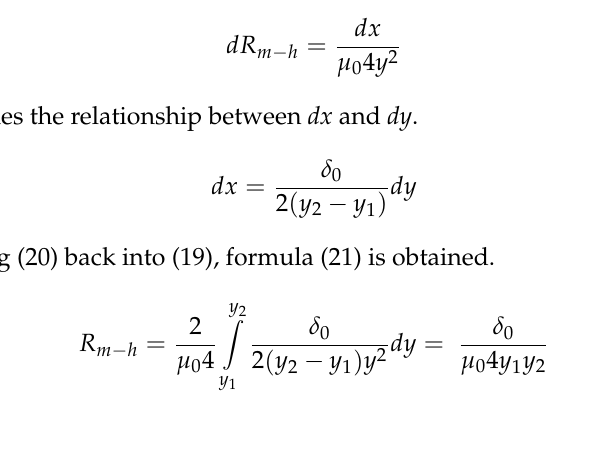
Figure 4. The illustration of the geometry of the elements P g , P 1 , and P 3 .